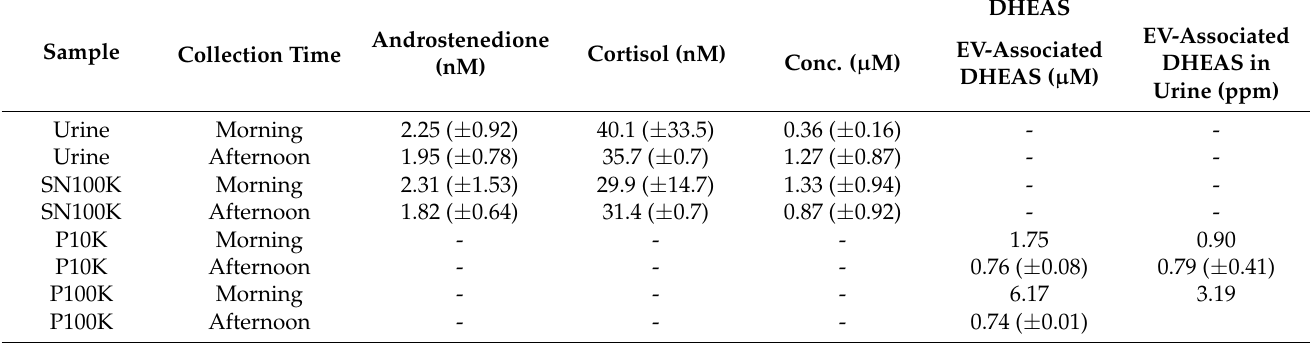
Table 4. Quantitation of urine human samples ( n = 6, U001 to U006, Table S4, Supplementary Materials). The isolated EV fraction are also included in the table. In the table, the three analytes detected in the urine-derived